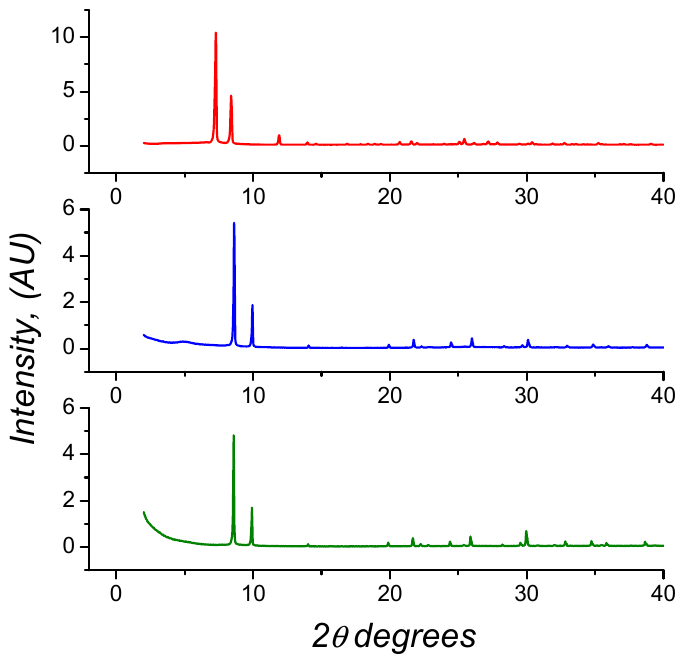
Figure 3. X-ray diffraction patterns of the synthesized MOFs: ( top ) Muc-Zr MOF; ( middle ) MIP-202 MOF and ( bottom ) MOF-801.